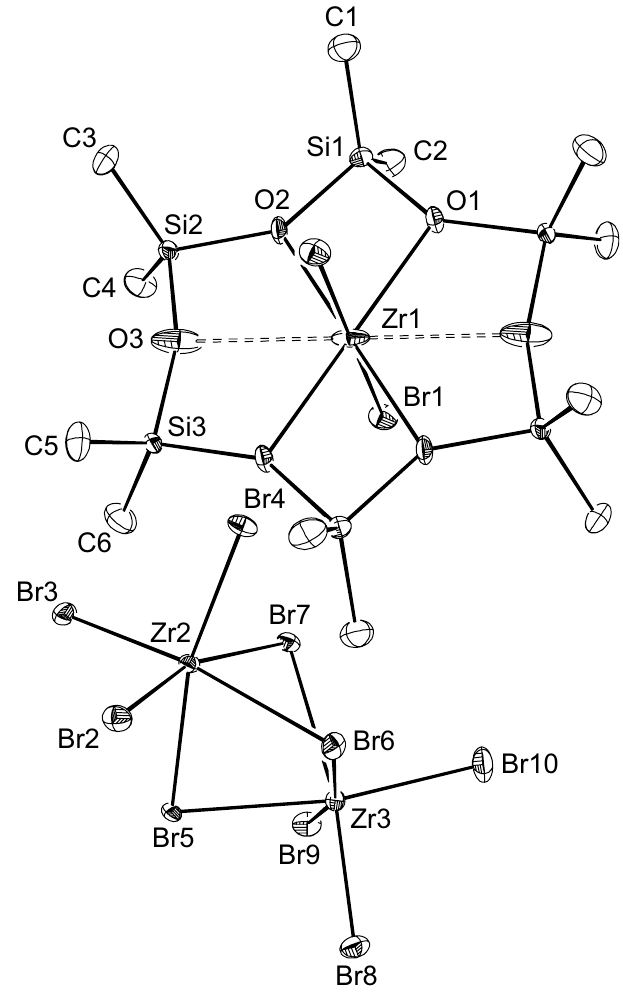
Table 2. Atomic coordinates and displacement parameters (in Å 2 )